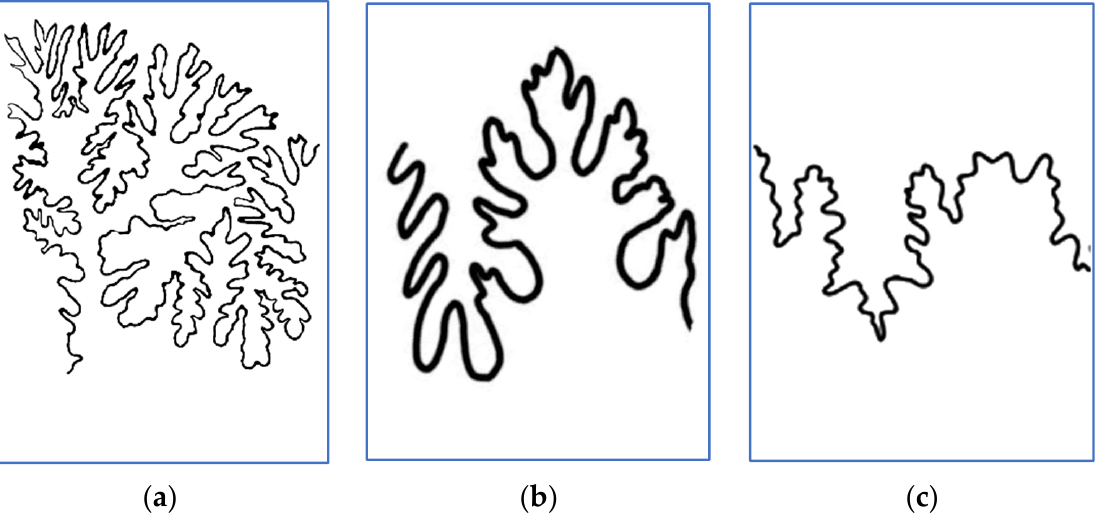
Figure 1. ( a ) Second Hemilytoceras fraasi , (number 15 its ontogenetic sequence). ( b ) Phylloceras sp., number 6 in its sequence. ( c ) Strajevskya strajevskyi , number 10 in its sequence.